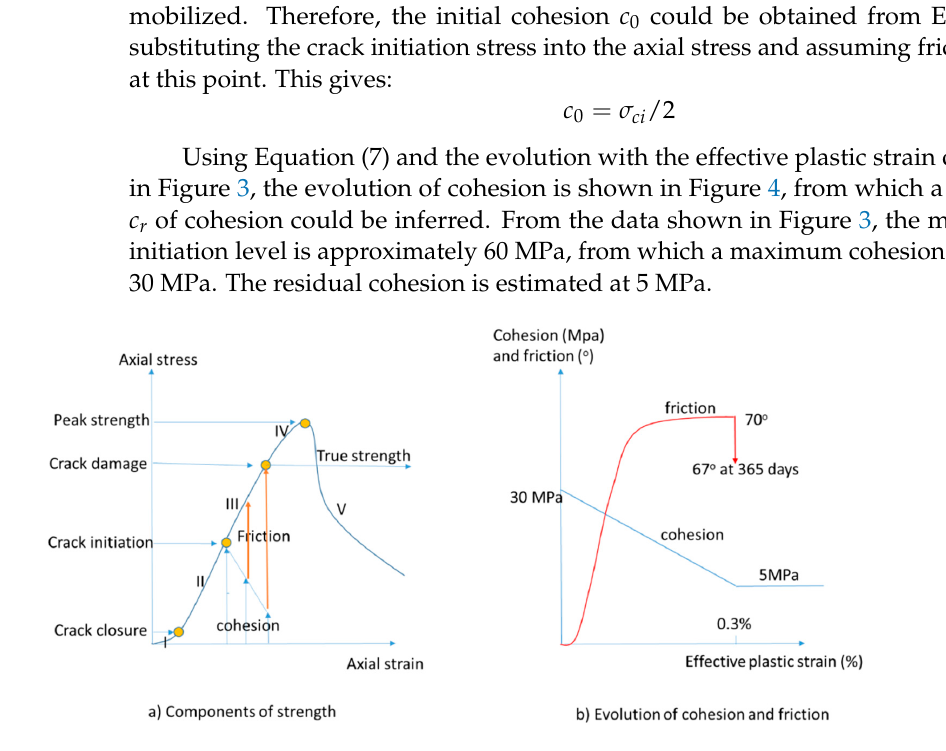
Figure 4. Evolution of cohesion and friction angle of LdB granite in uniaxial compression tests: ( a ) components of strength. Departure from elastic behaviour starts at the crack initiation level, with a cohesion loss accompanied by friction mobilization. The true strength is at the crack damage level. ( b ) Asynchronous cohesion loss and friction mobilization assumed in this study. Friction is also assumed to degrade with